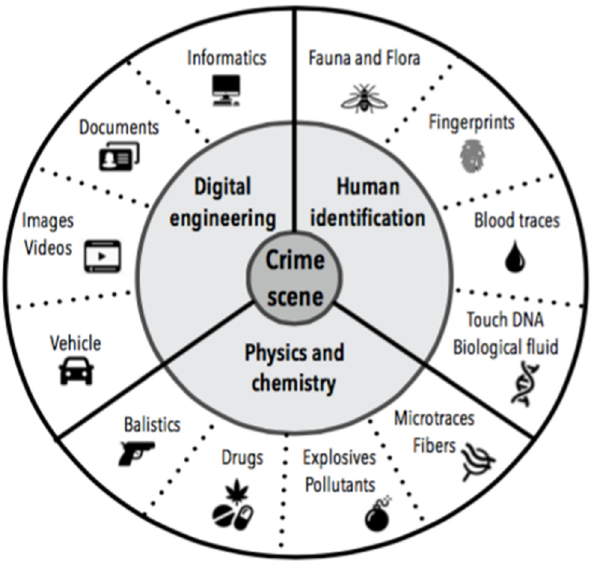
Figure 1. Some clues that can be recovered at a crime scene.